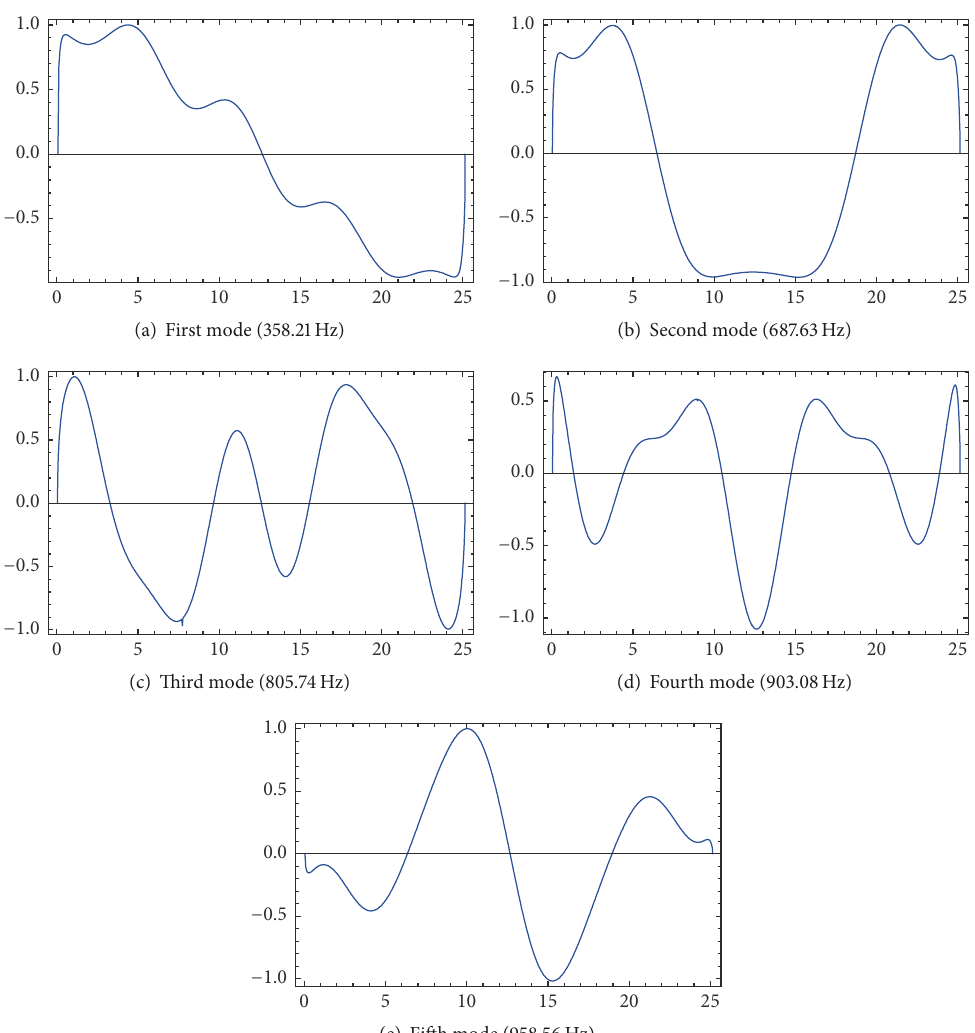
Figure 7: First five normal mode shapes of the generalized warping coordinate of Beam